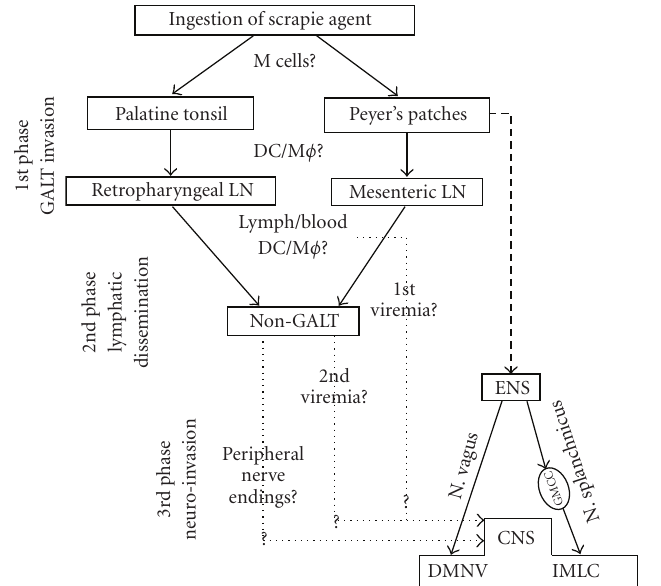
Figure 4: Pathogenesis of sheep scrapie. Permission was obtained for reproducing this figure originally published in [53]. For abbreviations see